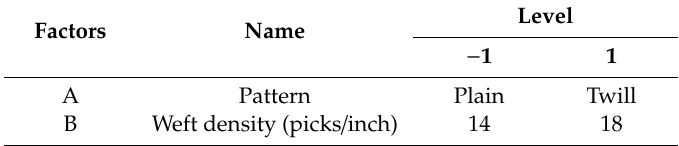
Table 3. Factors of the statistical design of experiments and their levels for mean pore size measurement. Factors